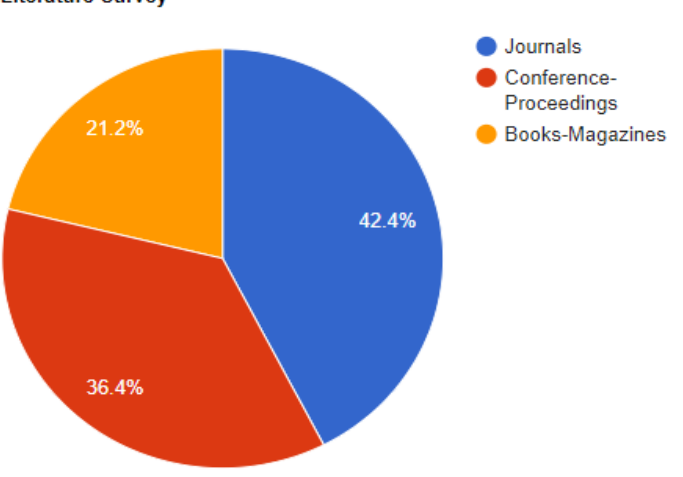
Fig. 2. Categories of resources referred for 5S literature